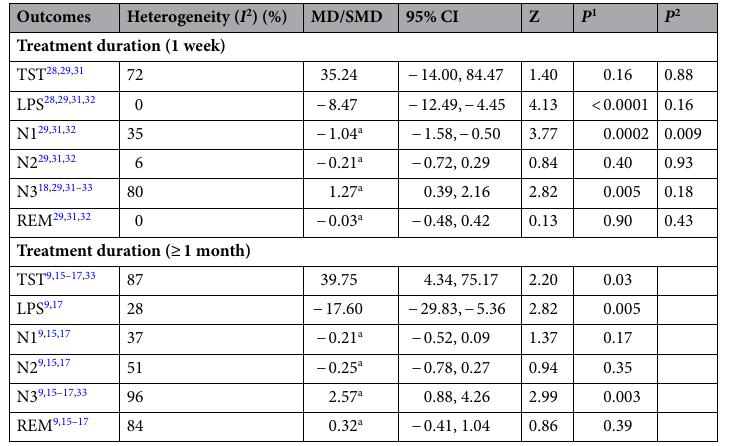
Table 5. Subgroups based on different treatment durations. CI confidence interval, LPS latency to onset of persistent sleep, MD mean differences, N1 non-rapid eye movement stage 1, N2 non-rapid eye movement stage 2, N3 non-rapid eye movement stage 3, P 1 variation within the group, P 2 differences between subgroups, REM rapid eye movement, SMD standardized mean differences, TST total sleep time. a